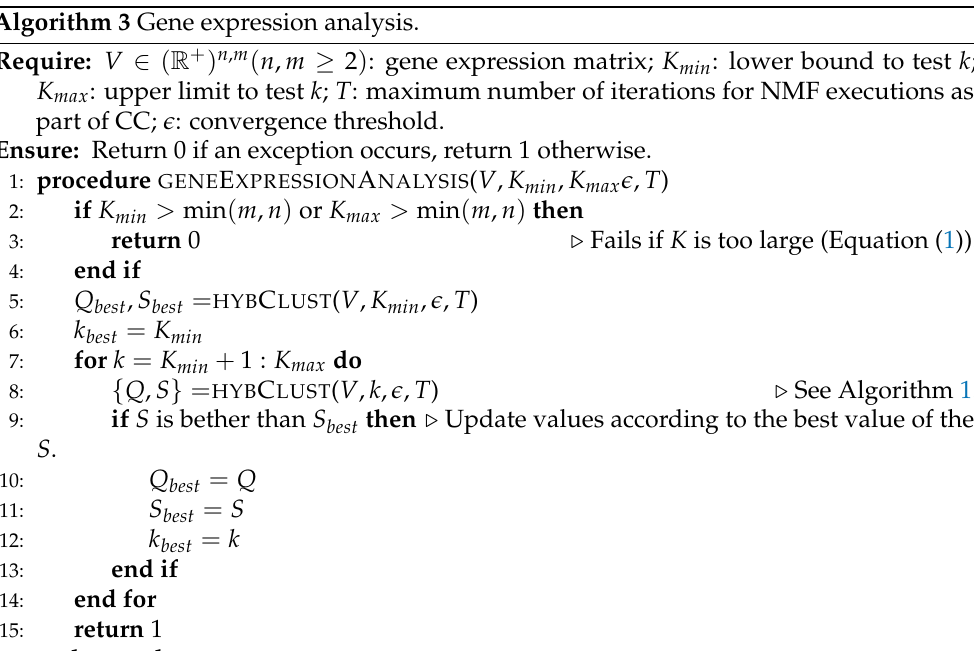
Algorithm 1 was executed for different values of k as described in Algorithm 3 in order to obtain their optimal value. For each of the many executions, NMF carried out a large number of costly matrix operations. Therefore, line 4 in Algorithm 1 was the critical step. Algorithm 3 Gene expression analysis.